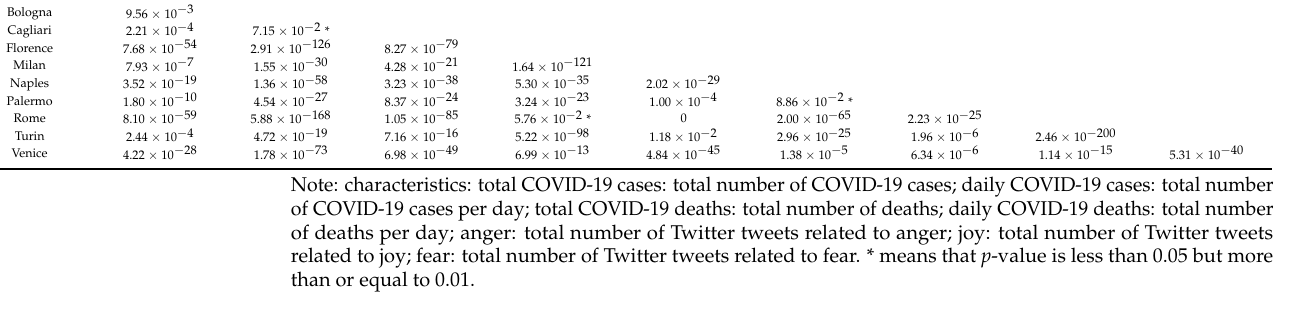
Table 2. Fear t-static values.